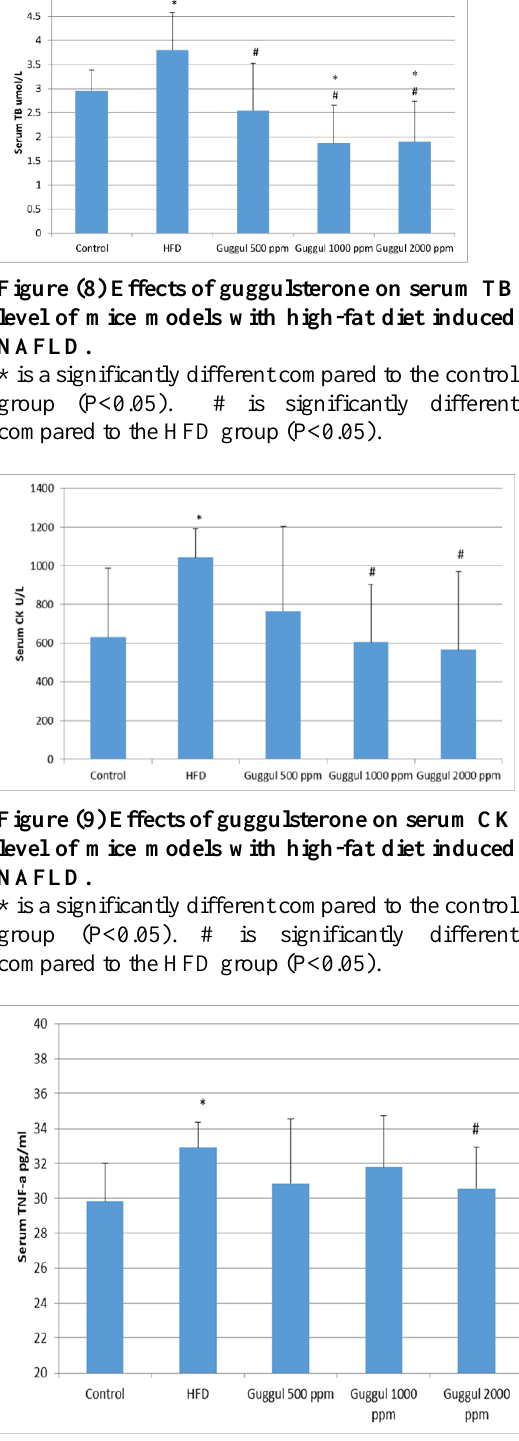
Figure (10) Effects of guggulsterone on serum TNF-α level of mice models with high-fat diet induced